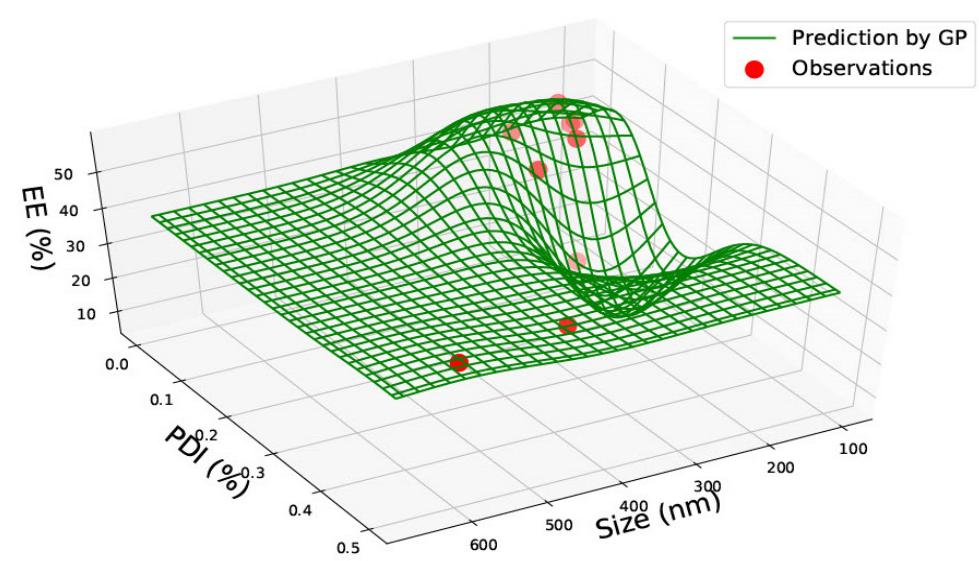
Figure 8. PLGA 75:25—size (nm), Polydispersity Index (PDI) and Encapsulation Efficiency (EE%).